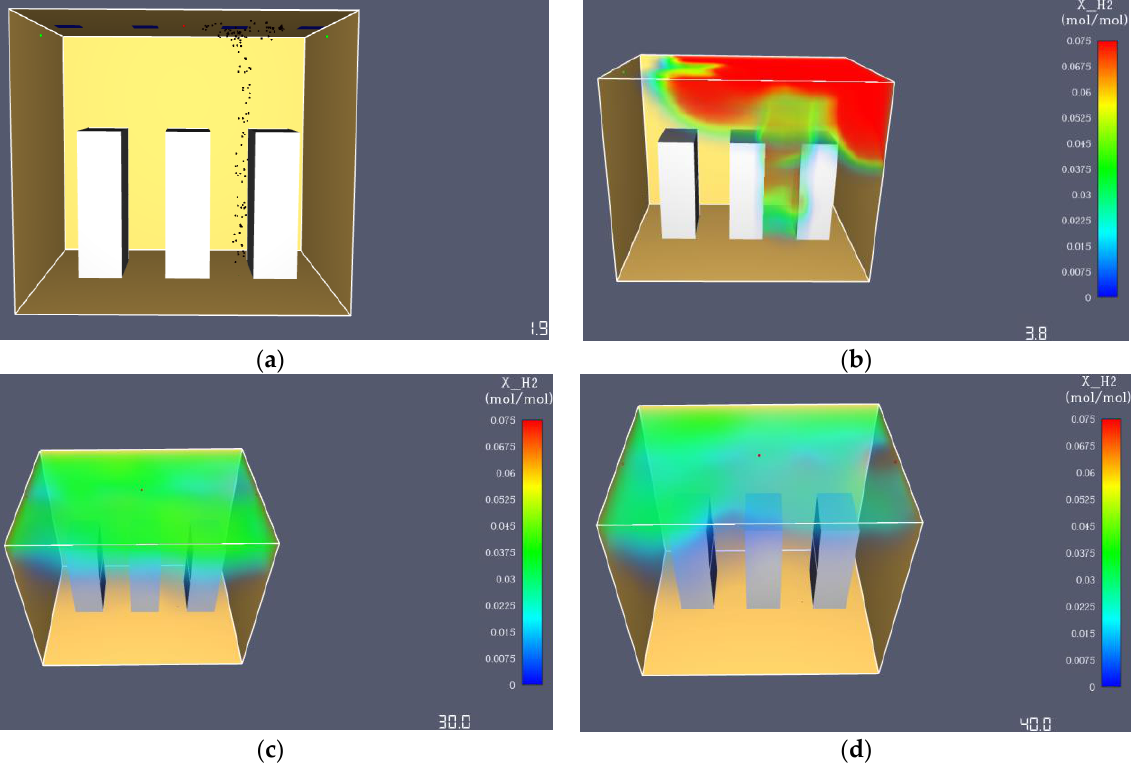
Figure 10. Leakage diameter 16 mm at the inlet of the bottom right stack: ( a ) detection at 1.9 s; ( b ) concentrations at 3.8 s; ( c ) concentrations at 30 s; ( d ) concentrations at 40 s. By increasing the ventilation rate from 30 to 60ACH, flammable masses were released much faster at 18 s, resulting in lower ignition risk (Figure 11). Maximum